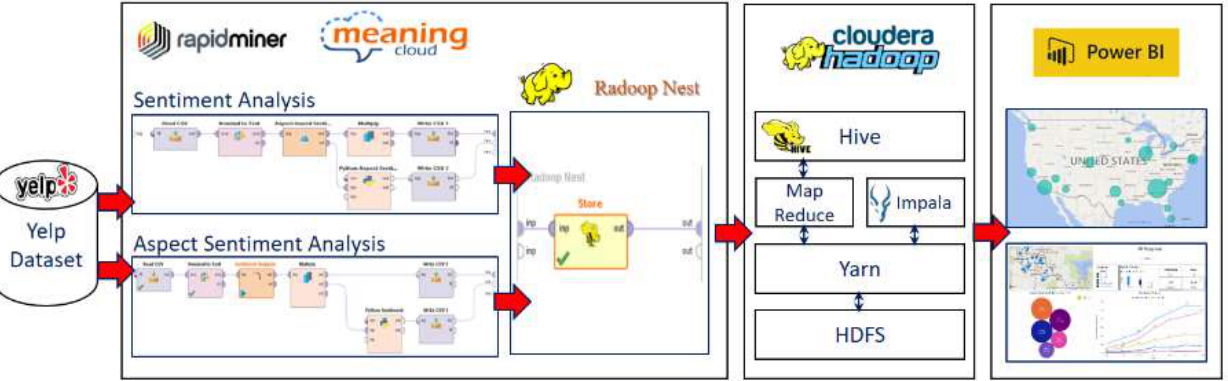
Figure 9. SCDAP for VoP Physical Realization.